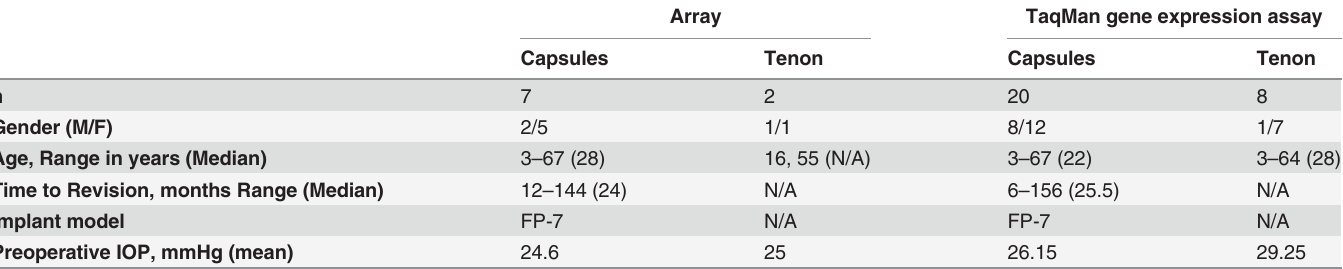
Table 1. Demographic data and clinical parameters of